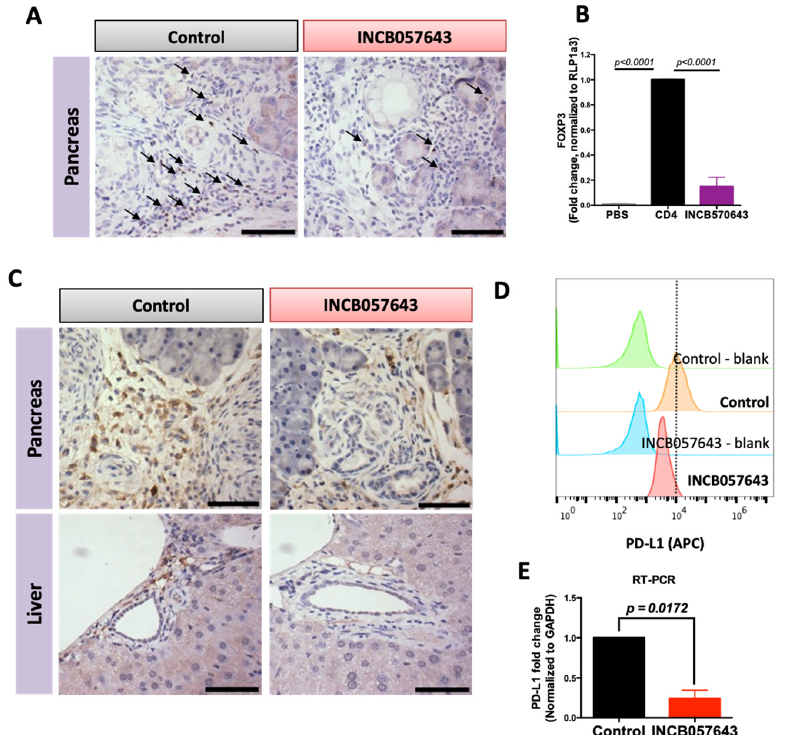
Figure 3. INCB057643 reduces the expression of FOXP3 in CD4 T cells and PD-L1 expression in macrophages. Immunohistochemistry for FOXP3 ( A ) or PD-L1 ( C ) in pancreas and liver of KPC mice treated with vehicle control or INCB057643 for 16 weeks. Scale bar = 30 µm. ( B ) CD4 T cells were isolated from a spleen of a wild type mouse using negative magnetic bead selection. CD4 T cells were plated with anti-CD3 (or PBS, a control for non-stimulated T cells), anti-CD28, IL-2 and TGF- β for 24 h prior to adding INCB057643 (100 nM) for 4 days. CD4 T cells were collected and levels of FOXP3 were determined by PCR. p < 0.001 vs. control CD4 cells in 2 independent experiments. ( D ) RAW 264.7 macrophage-like cells were treated with conditioned media from PanAsc 2159 cells; representative histograms for levels of PD-L1 analyzed by flow cytometry after treatment with 0.5 μ M INCB057643 for 24 h are shown ( n = 2) and confirmed by RT-PCR ( n = 3) ( E ).